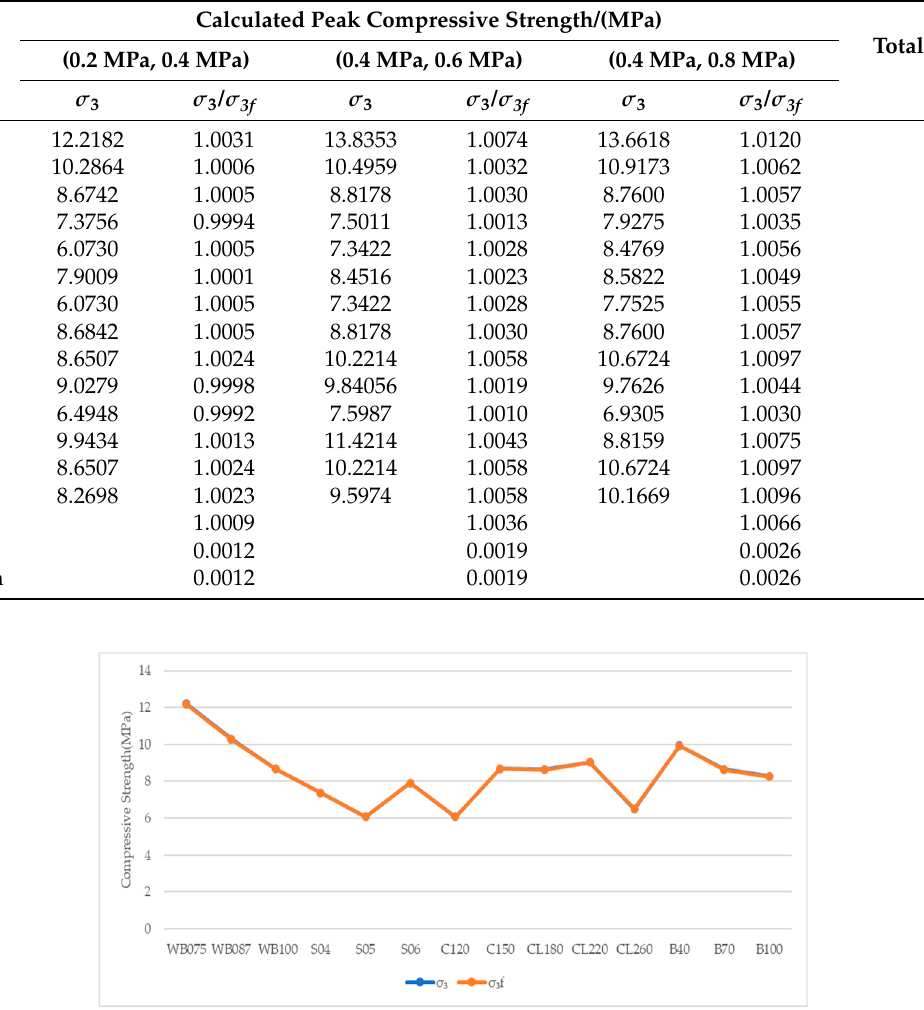
Figure 3. Comparison of Peak Compressive Strength between Calculation and Test with Confining pressure (0.2 MPa, 0.4 MPa).